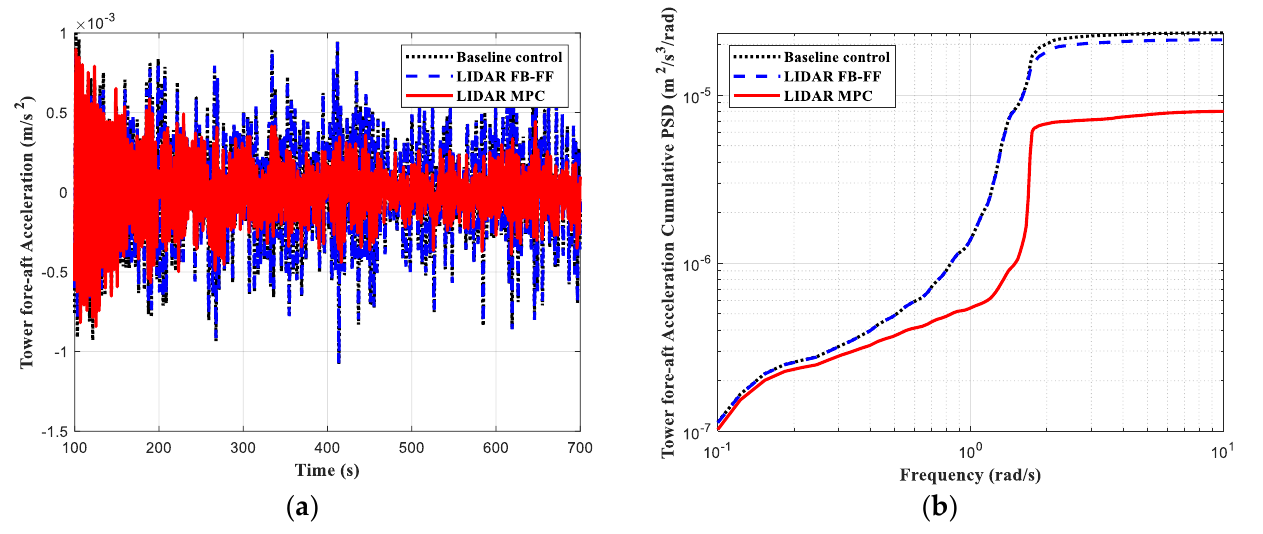
Figure 12. Out-of-plane rotor torque: ( a ) time profiles; ( b ) cumulative PSD (for wind speed with 15% turbulence intensity).